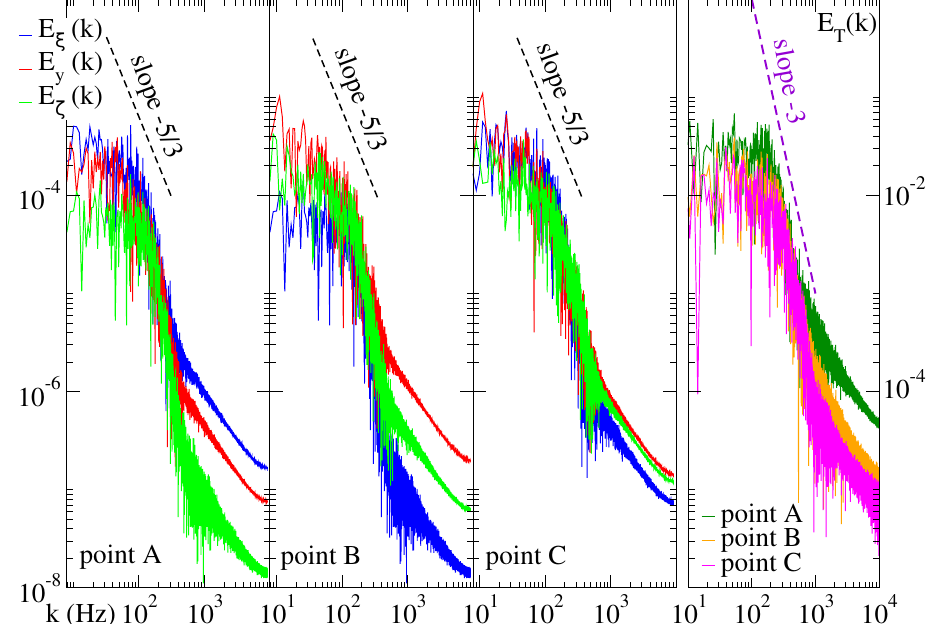
Figure 5. Power spectra of the three velocity components in the system of reference of the slope ( E i = E u ) and temperature perturbation ( E T ) at three selected points within the convective region i u i near the slope. Points placed at different heights at the slope-normal line passing through the slope mid-point ( ξ / L = 0.5): point A ( ζ / H = 0.12), point B ( ζ / H = 0.3), point C ( ζ / H =